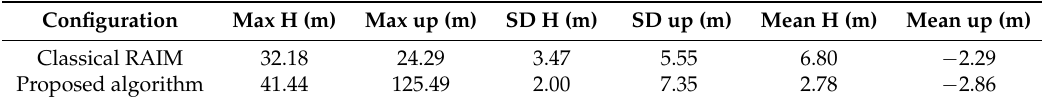
Table 11. Position error statistics considering only reliable epochs. Classical RAIM is used as the term of comparison.